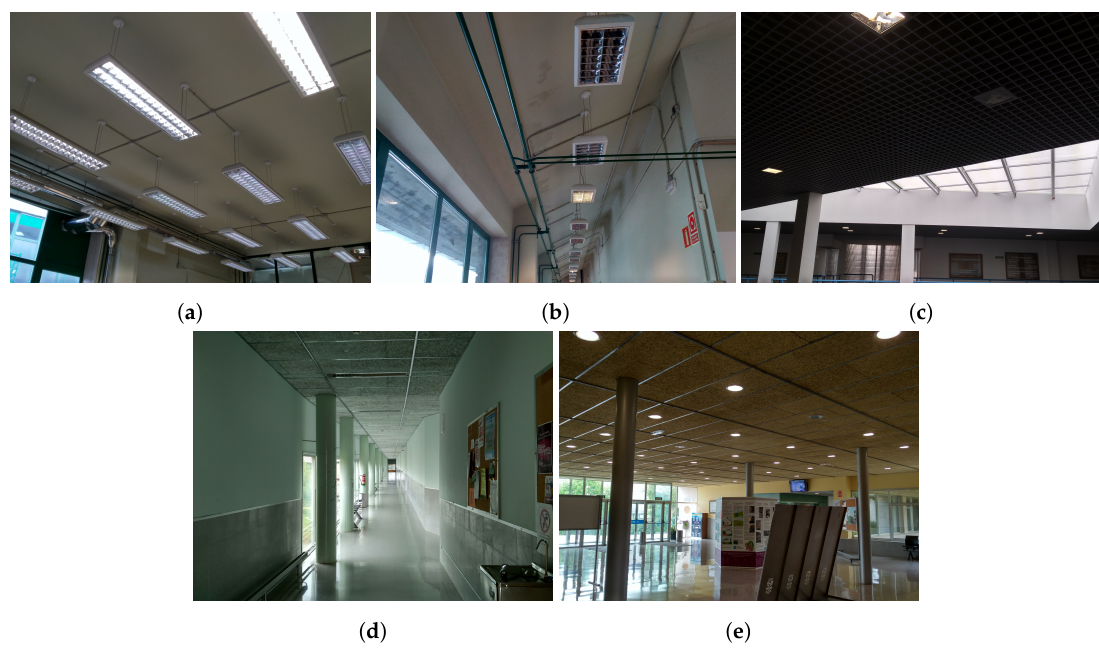
Figure 4. Spaces for the five case studies used to evaluate the system: ( a – e ) Case studies 1 to 5. Table 1. Description of the complete dataset used, including a description of the physical space, the model number and the number of images, lamps and lamps turned